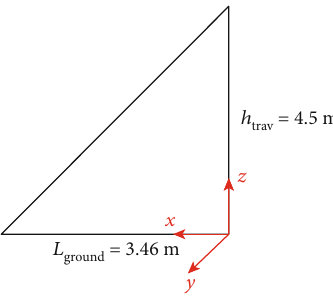
Figure 7: Coordinate system in NEST. The coordinate system ’ s origin is the base plate in the middle of the traverse poles. x points towards the starting point of the lander, y appropriate normal, and z vertical. L is the distance to the middle of the traverse poles ground is their height. This leads to coordinates of the turning and h trav wheel: (0, 0, 4, 5).